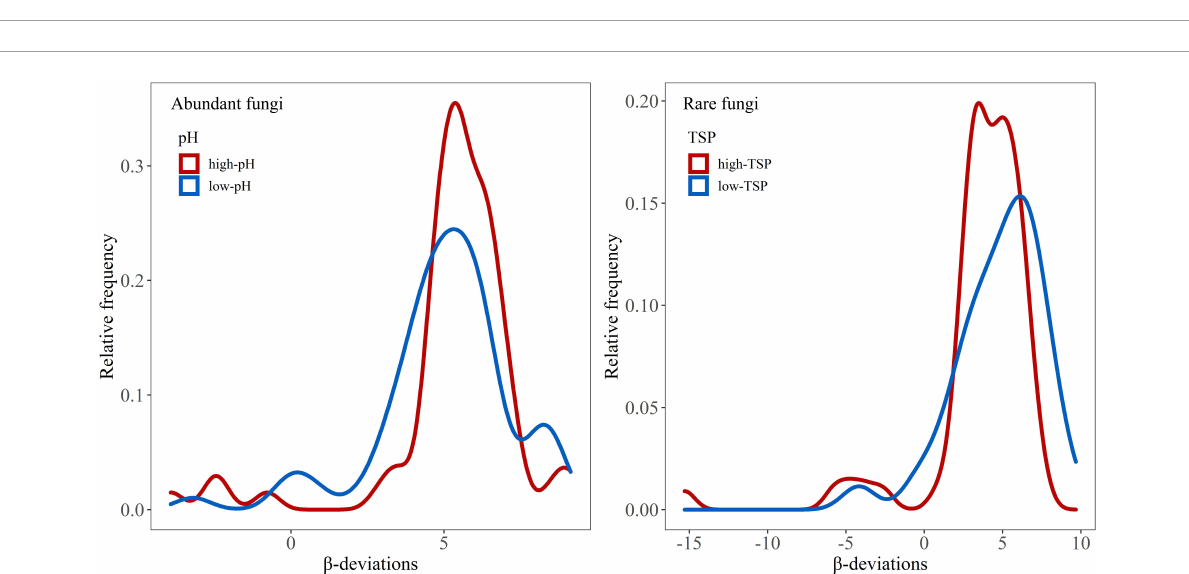
FIGURE6 β -deviations distributions of abundant and rare fungi in different soil pH and STP gradients, respectively. These two categories (i.e., high-pH vs. low-pH) were divided by standardizing the number of samples in each category, which is more reasonable when comparing distinct categories (Jiao et al.,